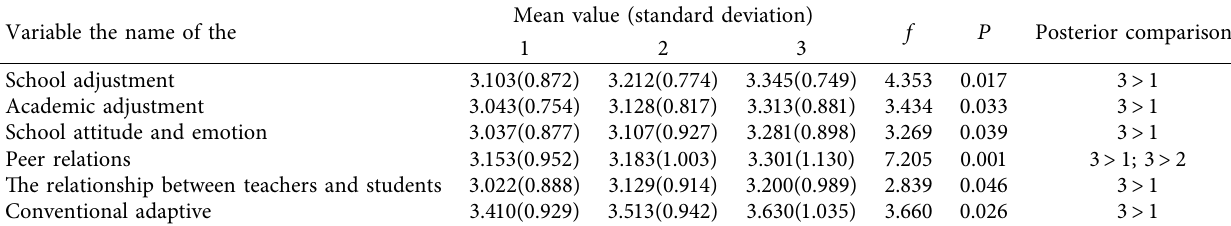
Table 5: Summary table of school adaptation difference analysis of middle school students in different grades. Variable the name of